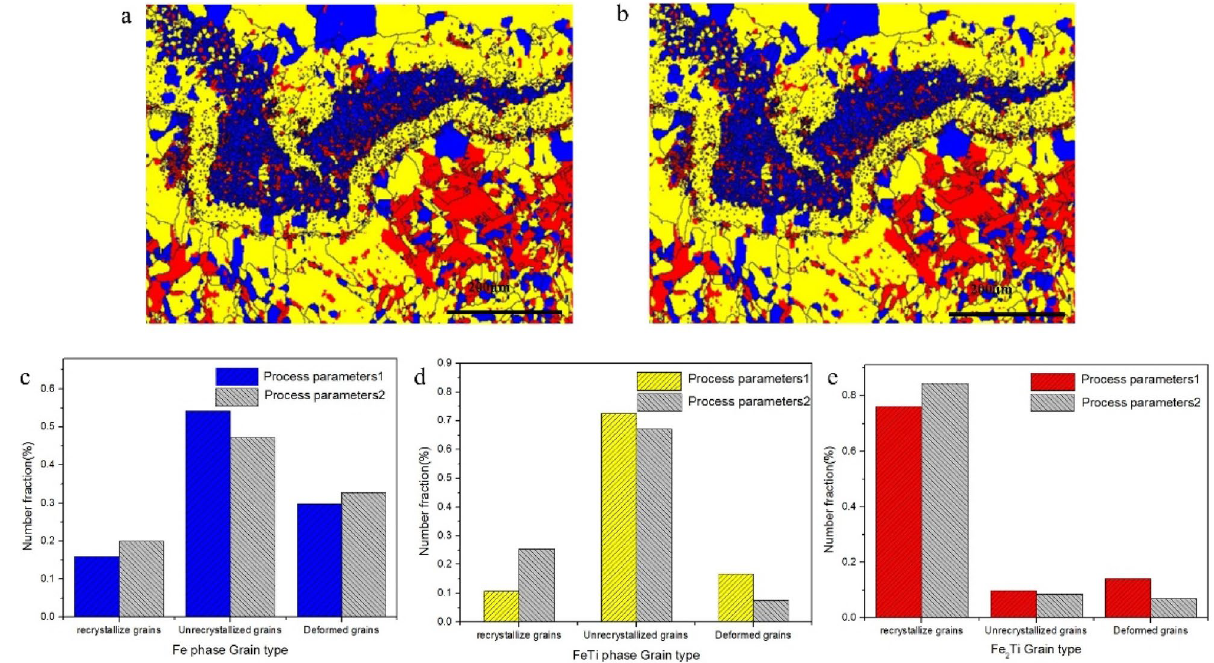
Figure 8. Recrystallization distribution and volume statistics of different phases. (a) First welding parameter. (b) Second welding parameter, (c) Fe recrystallization volume statistics. (d) FeTi recrystallization volume statistics. (e) Fe 2 Ti recrystallization volume statistics. In this graph, Blue color is for recrystallized grains, Yellow for un-recrystallized grains, and Red for deformed